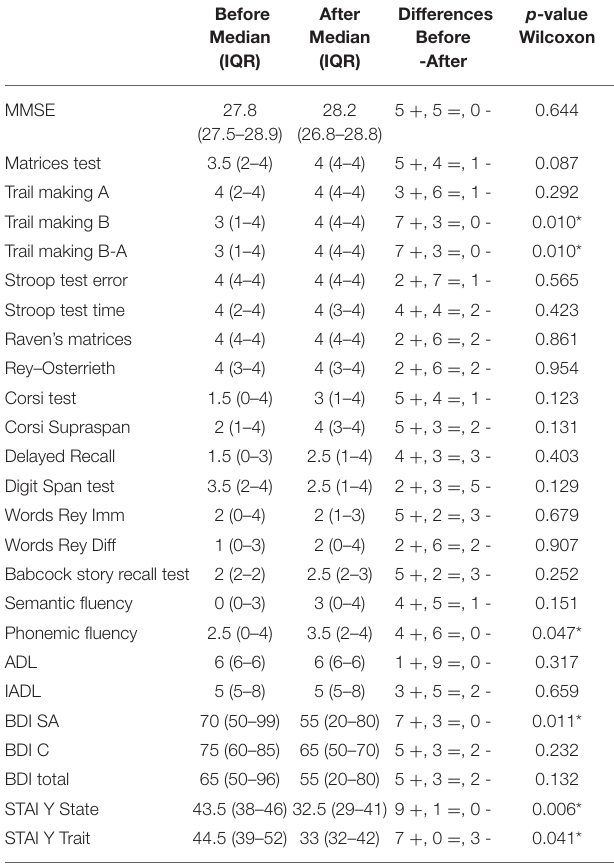
TABLE 4 | Comparison of neuropsychological status before and after ETV.